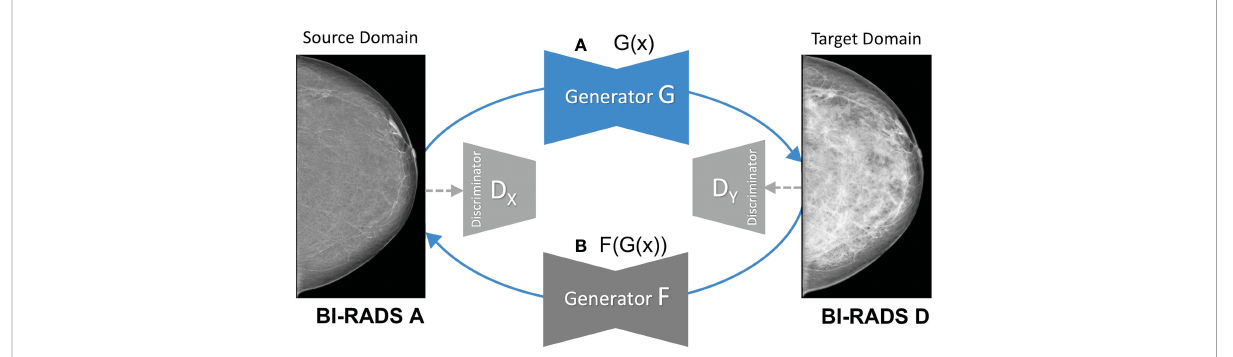
FIGURE 2 Overview of the mapping functions of the CycleGAN framework. (A) shows the mapping of a low-density mammogram (source domain) via generator G to a high-density mammogram (target domain). (B) depicts the mapping of a synthetic high-density mammogram back to the low- density source domain via generator F